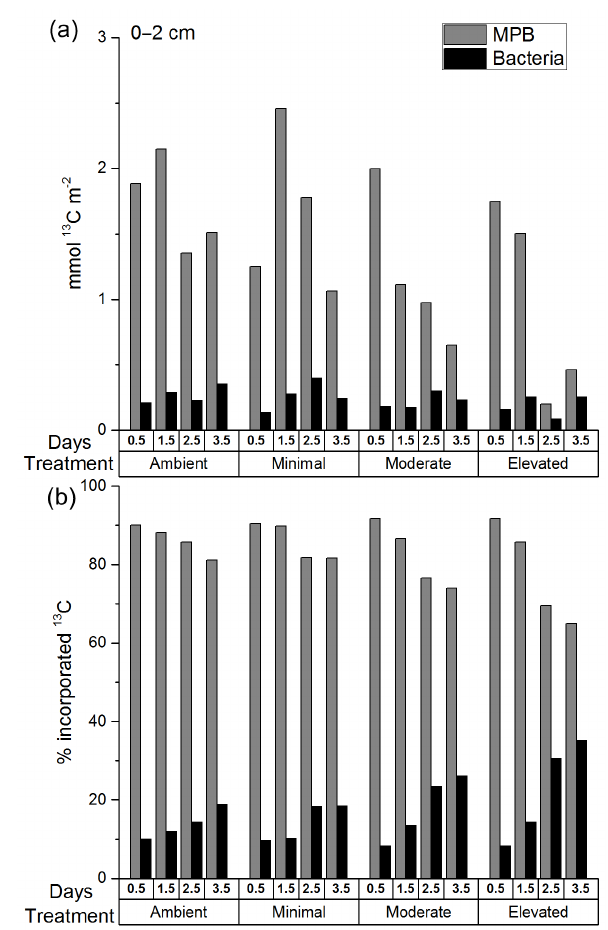
Figure 4. The 13 C within MPB and bacterial biomass in sediment at 0–2cm depth as (a) total excess 13 C (mmol 13 Cm − 2 ) and (b) a percentage of the total 13 C in microbial biomass at 0–2cm at each time period. There are no error bars as PLFAs were analyzed for only one replicate sample from each time